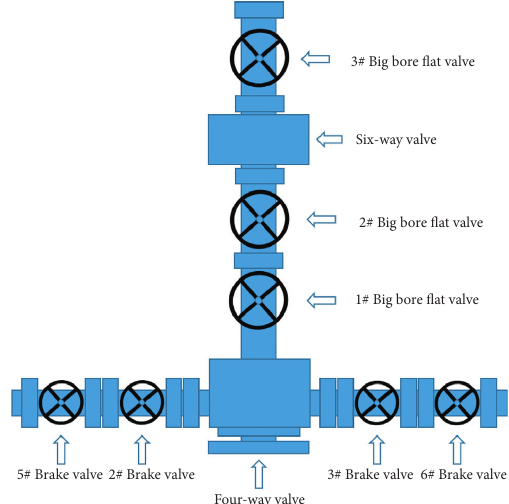
Figure 1: Schematic diagram of wellhead installation of gas production